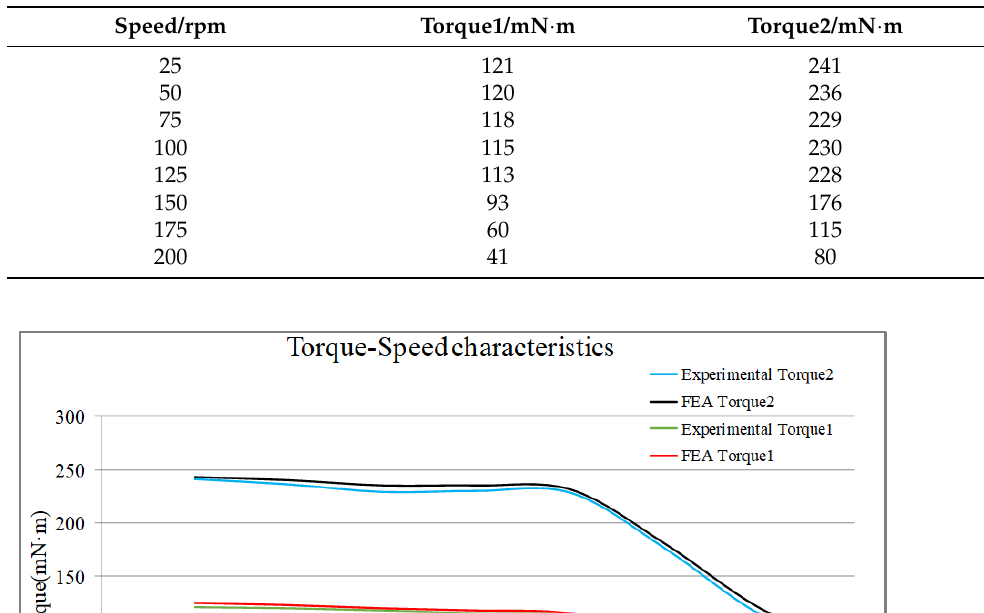
Figure 10. Experimental platform for the prototype of the motor. Table 4. Experimental Results.